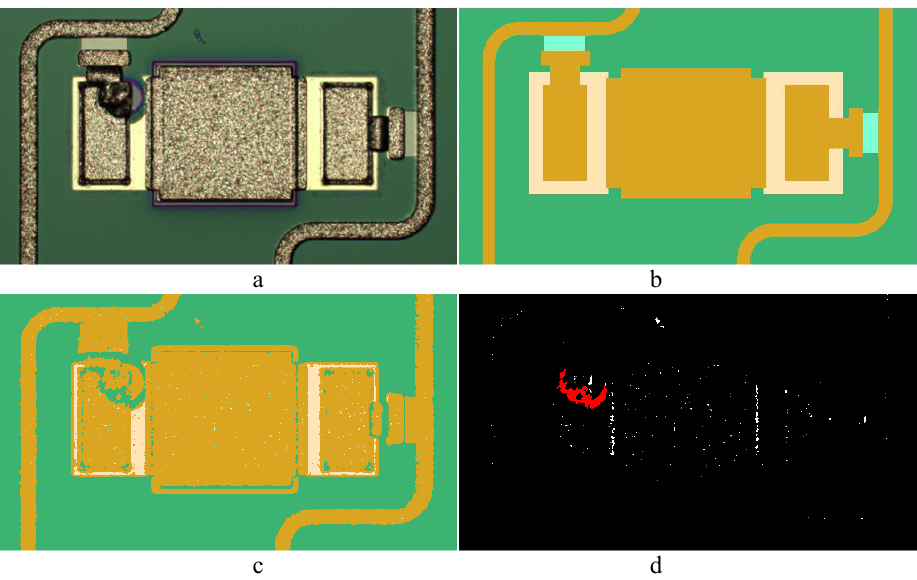
Fig. 3. An algorithm operation example for automated visual inspection in the microphotograph part of an MMIC with a defect. a) The microphotography MMIC initial part. b) The part of the rasterized photomask matching to the MMIC microphotograph part. c) The MMIC microphotography part converted using a classifier based on an artificial neural network. d) The binary transformed defect map with a selected cluster indicating the defect presence in the MMIC microphotograph